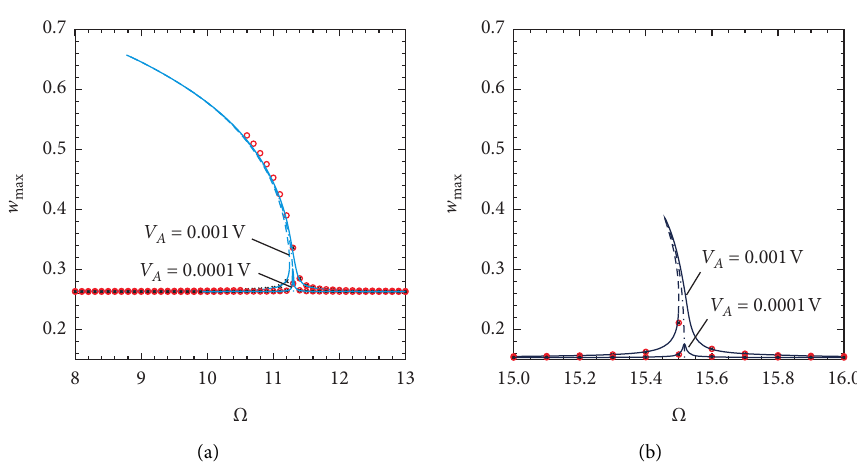
Figure 18: Amplitude-frequency curve: V